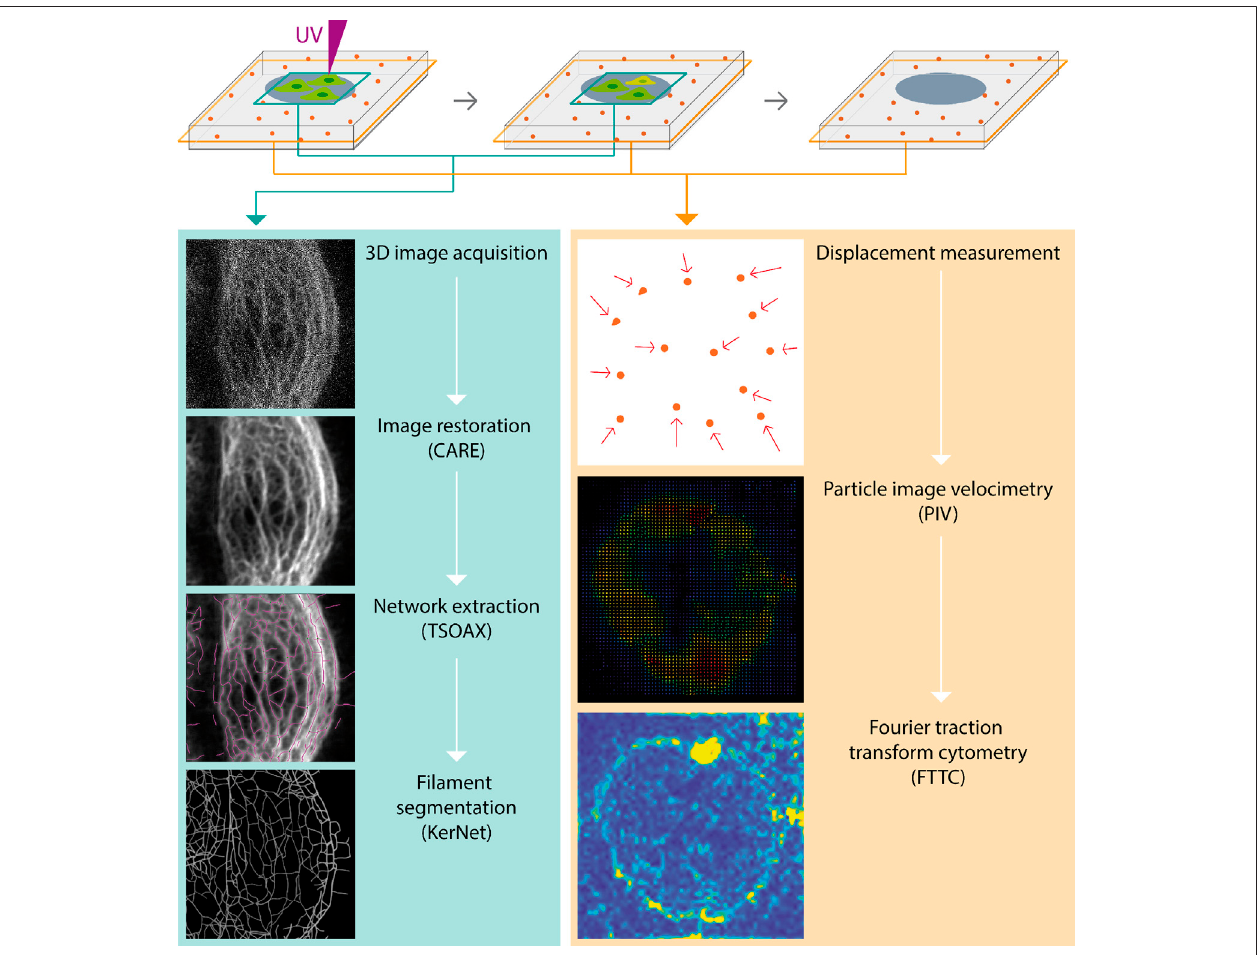
FIGURE 2 | The scheme shows the work fl ow to analyze complete cellular KF networks in parallel with traction force measurements of cells growing in de fi ned microenvironments. Stacks of fl uorescence recordings of fl uorescent protein-tagged KFs are processed with the help of a deep-learning based image restoration protocol (CARE) to enhance images to such a degree that they allow complete digital KF network representation. This is done by extracting chains of vertices (TSOAX) that are connected by nodes using KerNet. The resulting numerical representation of single KF segments can be interrogated for various properties such as segment length, curvature and orientation. In parallel, images of fl uorescent beads embedded in the underlying elastic substrates are acquired in a separate channel. Displacementofthe fi ducialbeadsaftercellremovalisdeterminedbyparticleimagevelocimetry(PIV)tomeasuretheirdisplacement,whichcanberepresentedasvector maps (directionality and magnitude of displacement) or heatmaps (magnitude of displacement). The resulting displacement data are then used for the calculation of traction forces by Fourier traction transform cytometry (FTTC).